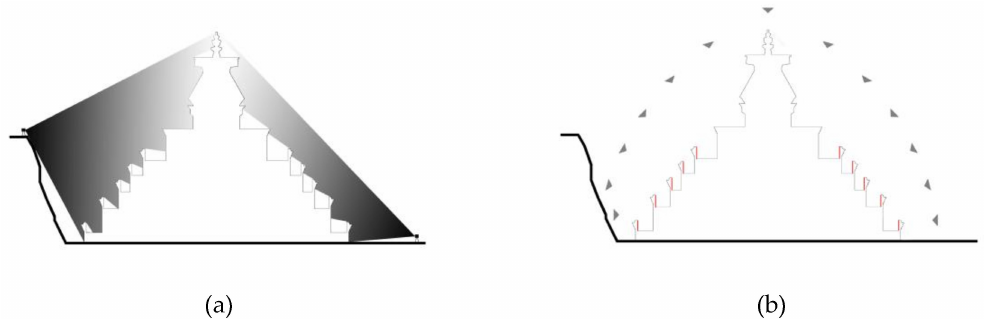
Figure 13. Coverage of TLS ( a ) and UAV-photogrammetry ( b ) in the Stupa dataset. Although the latter method generates a more complete model than that from TLS, the inner surfaces of the enclosures on each floor (highlighted in red) are still missing considering reasonable labor intensity and favorable camera